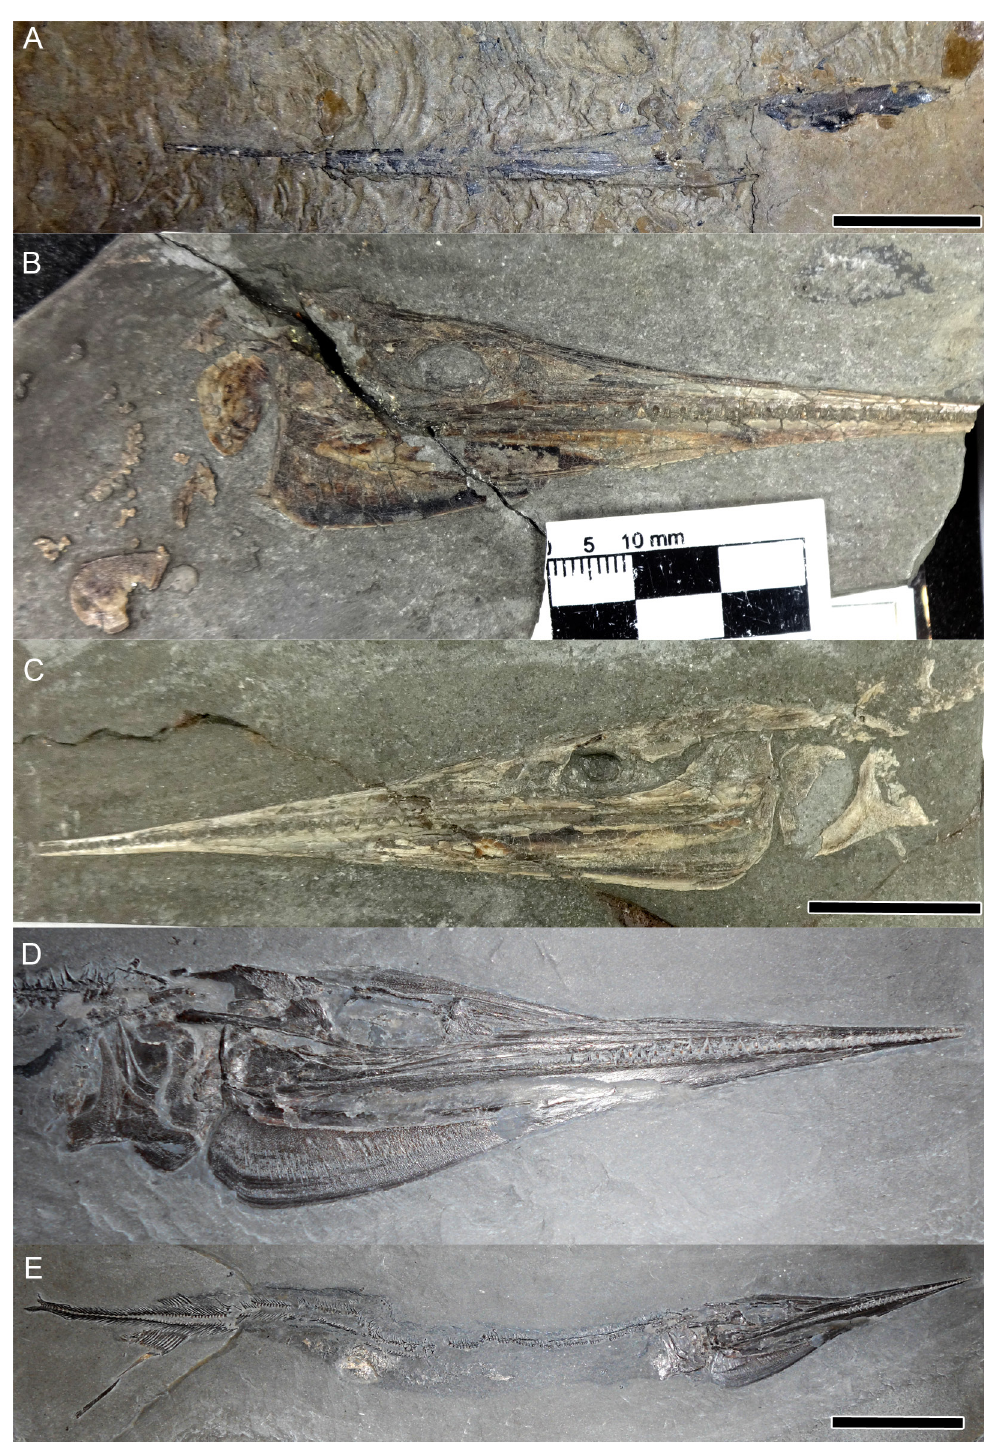
Fig. 1. Holotype specimens of Early Jurassic saurichthyids. A . Saurorhynchus acutus (Agassiz, 1844) (NHMUK PV P 4268). B . Saurorhynchus brevirostris (Woodward, 1895) (NHMUK PV OR 40726). C . Saurorhynchus anningae sp. nov. (NHMUK PV P 3791). D–E . Saurorhynchus hauffi sp. nov. (SMNS 55057). Scale bars: A, C = 20 mm; E = 50 mm. Photos A–C © The Trustees of the Natural History Museum,